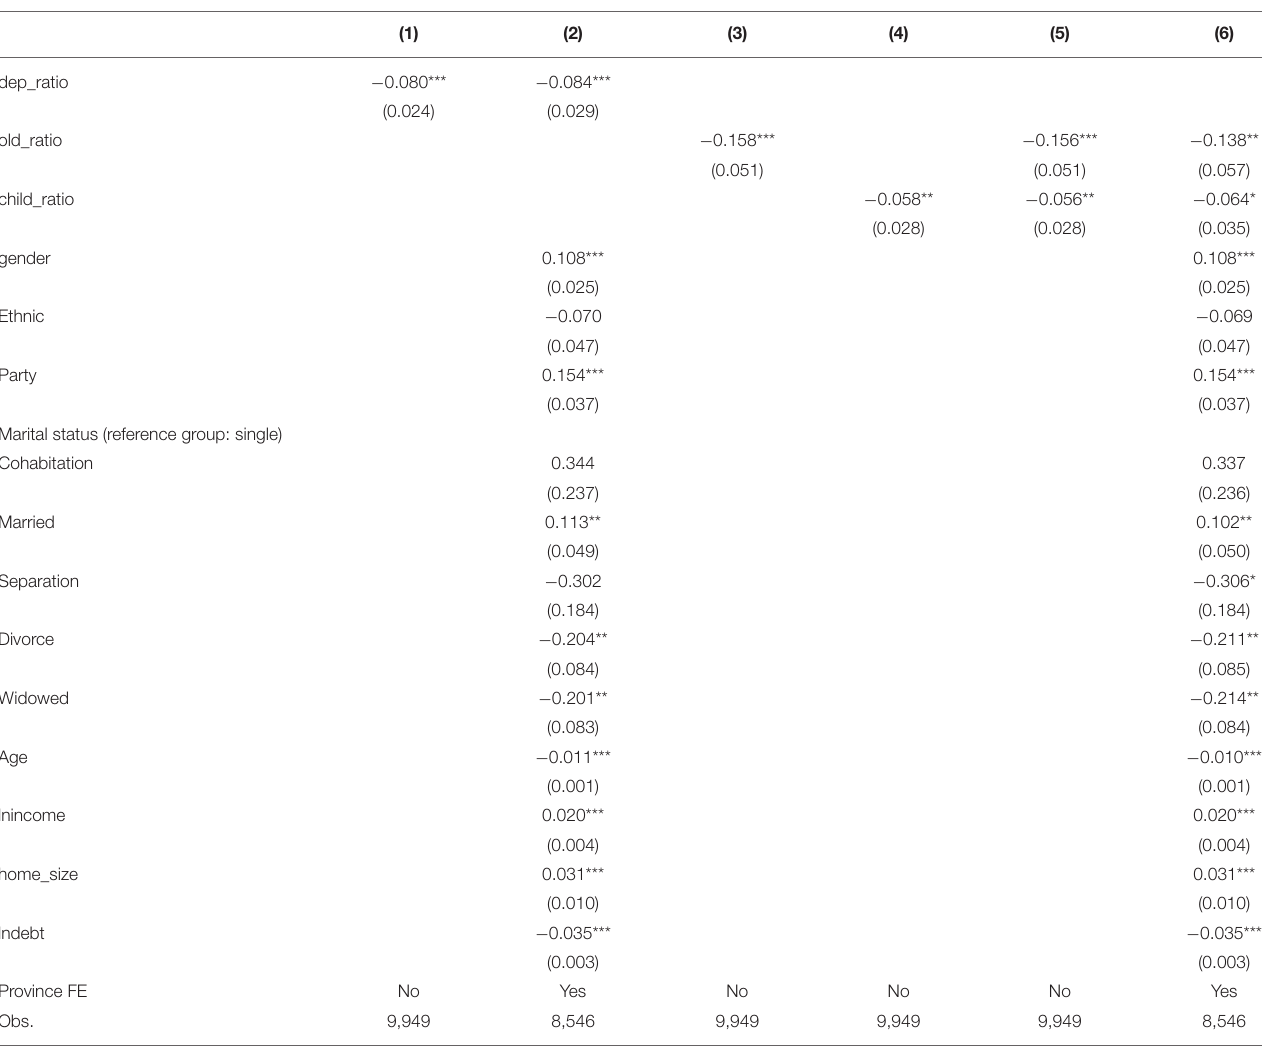
TABLE 2 | Baseline regression